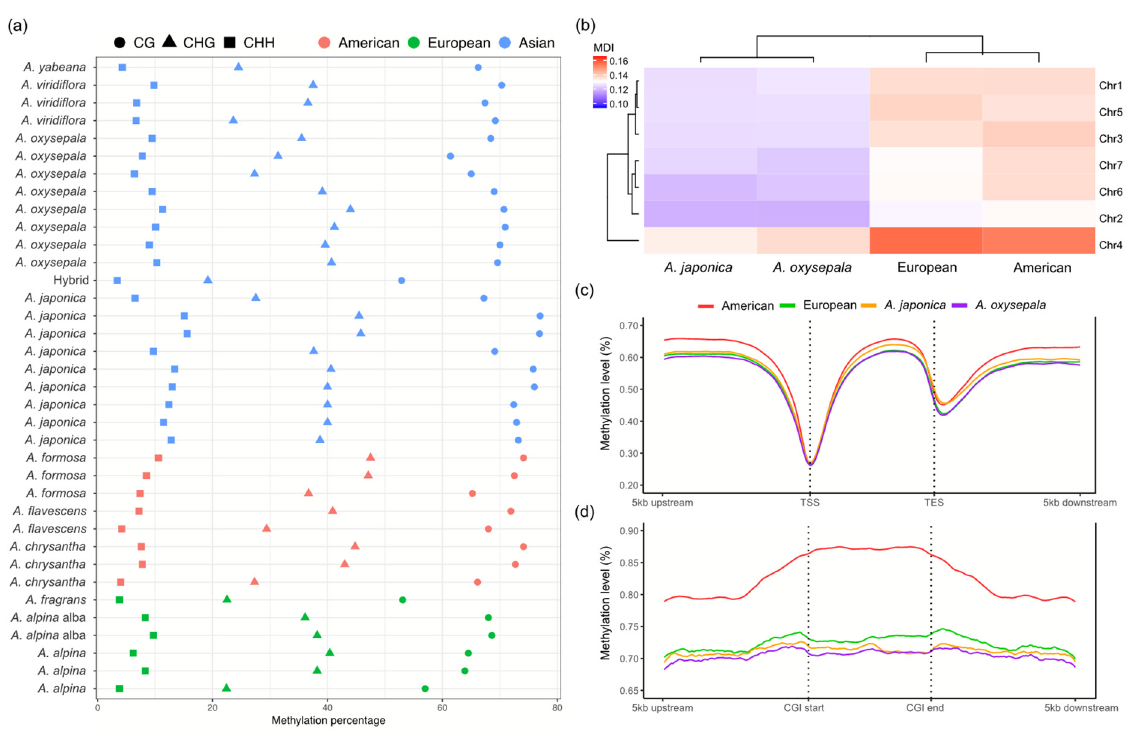
Figure 4. Patterns of cytosine methylation for the ten worldwide Aquilegia species. ( a ) Genome-wide cytosine methylation levels of 36 accessions. ( b ) MDI illustrates chromosome-level CG methylation similarity. Aquilegia viridiflora was used as the reference. ( c ) CG methylation profiling in genic region across the four Aquilegia groups. Each row represents one genic region starting at 5-kb upstream of its TSS and terminating at 5-kb downstream of its TES, sorted by mean methylation level of all the analyzed CG loci. Gene body regions were scaled to have the same length. ( d ) CG methylation profiling in and around the CG islands.